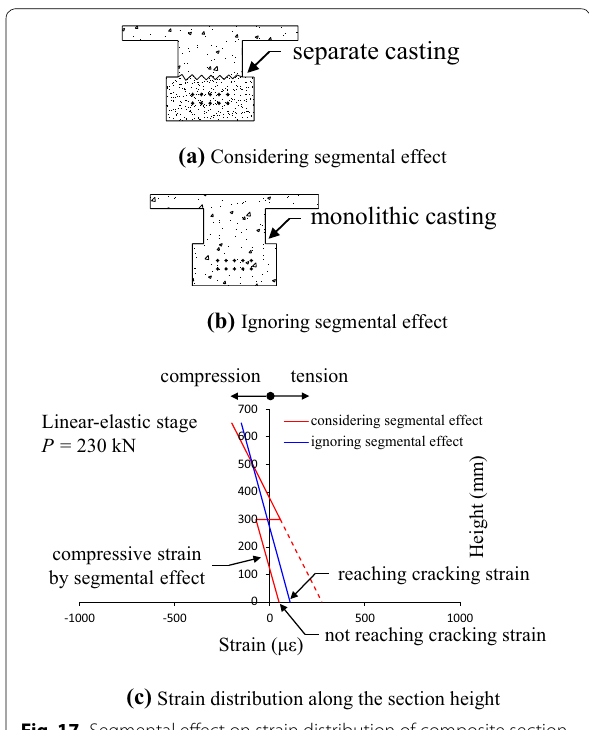
Fig. 17 Segmental effect on strain distribution of composite